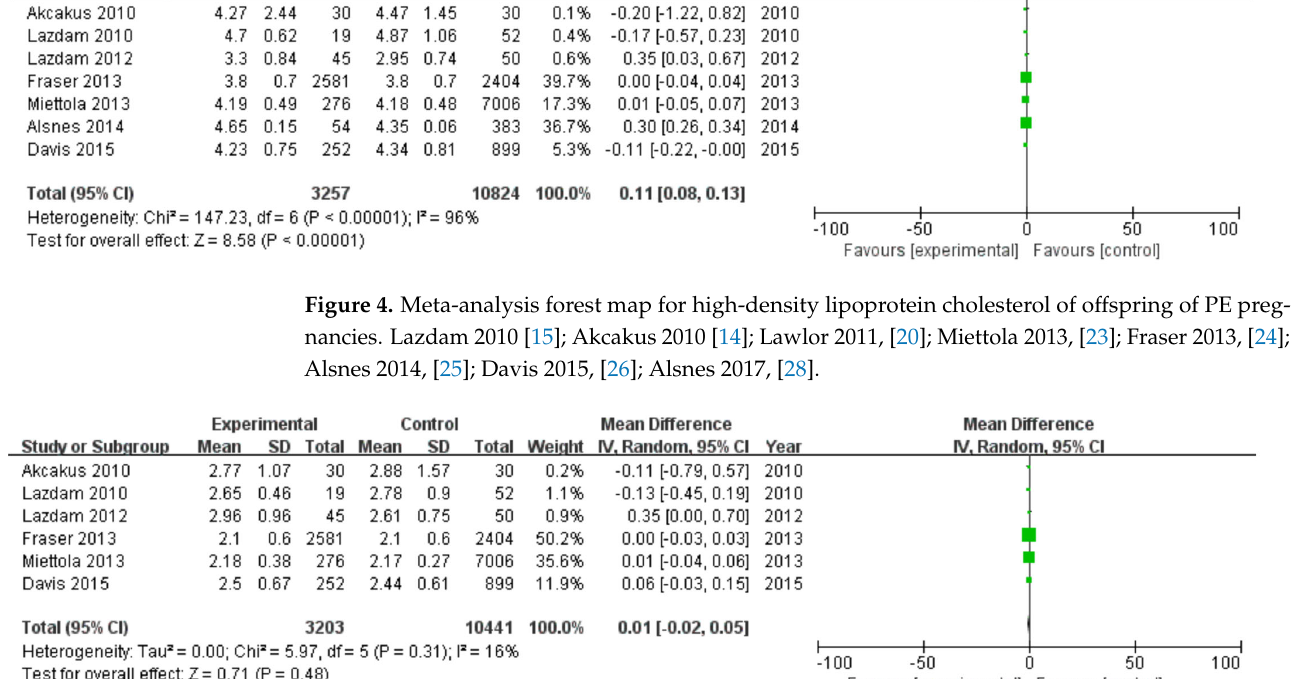
Figure 4. Meta ‐ analysis forest map for total cholesterol of offspring of PE pregnancies. Akcakus 2010